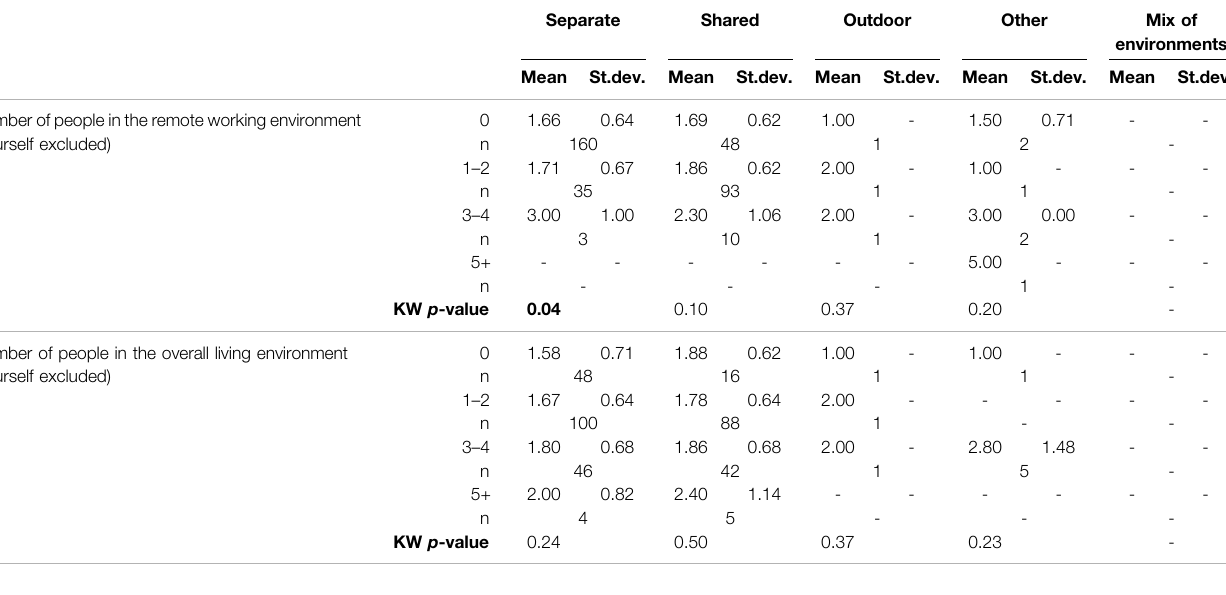
TABLE10| Meanandstandarddeviation(St.dev.)valuesoftheanswersgivenbynonsensitivetonoiserespondents( n (cid:1) 358)onnoiseannoyance(Q1)relatedtothenumber of people in the remote working environment and in the overall living environment. Two-tailed p -values of signi fi cance of the differences according to the Kruskal Wallis (KW) Test are reported. Statistically signi fi cant differences with p -values < 0.05 are reported in bold.